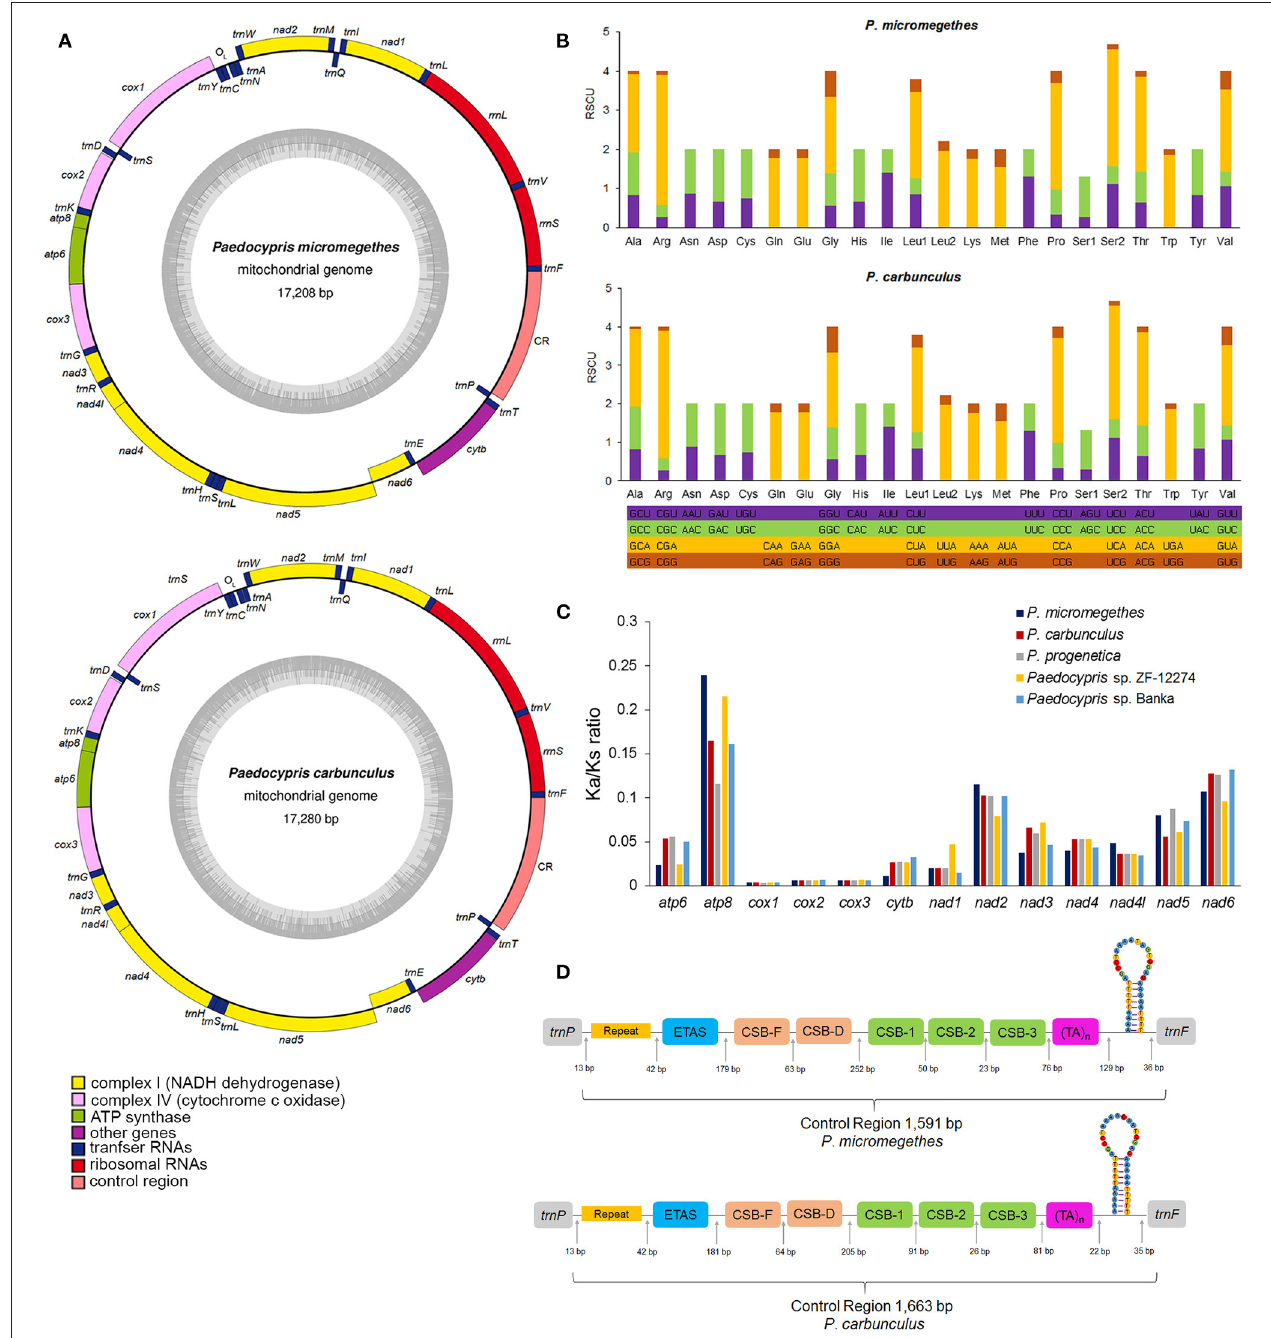
FIGURE 1 | The complete mitochondrial genomes of P. micromegethes and P. carbunculus. (A) Circular map of the P. micromegethes and P . carbunculus mitogenomes. (B) Relative synonymous codon usage of protein-coding genes in P. micromegethes and P. carbunculus mitogenomes. (C) The ratio of non-synonymous and synonymous substitution (Ka/Ks) estimated in all 13 mitochondrial protein-coding genes of Paedocypris species. (D) Control region of P. micromegethes and P. carbunculus mitogenomes. The structural elements were displayed in different colors.